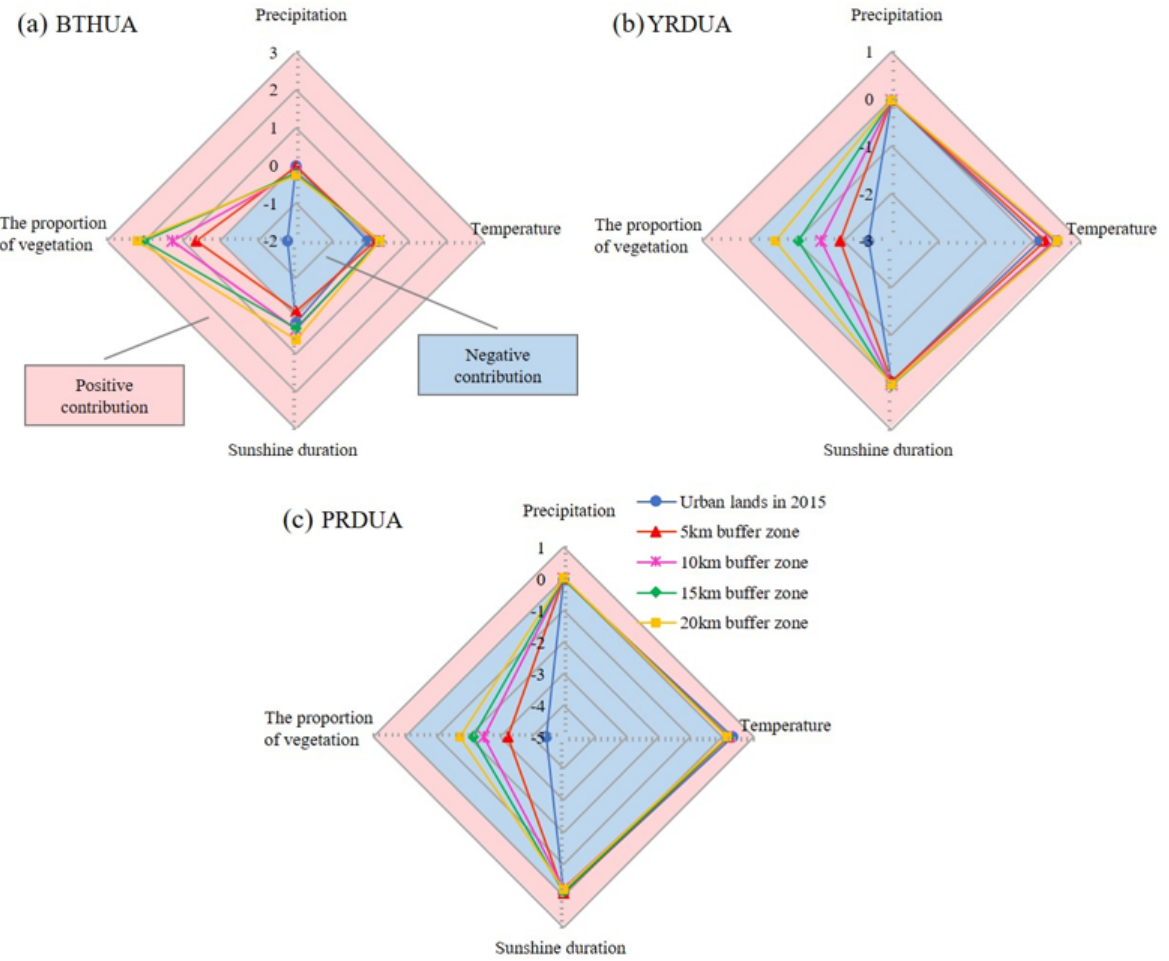
Figure 12. The contribution of the annual cumulative precipitation, the annual average air temperature, the annual cumulative sunshine duration, and the proportion of vegetation to the NPP trends in urban lands in 2015, also including the 5 km buffer zone, 10 km buffer zone, and 20 km buffer zone of ( a ) the BTHUA, ( b ) the YRDUA, and ( c ) the PRDUA (unit: g C/m 2 /yr).